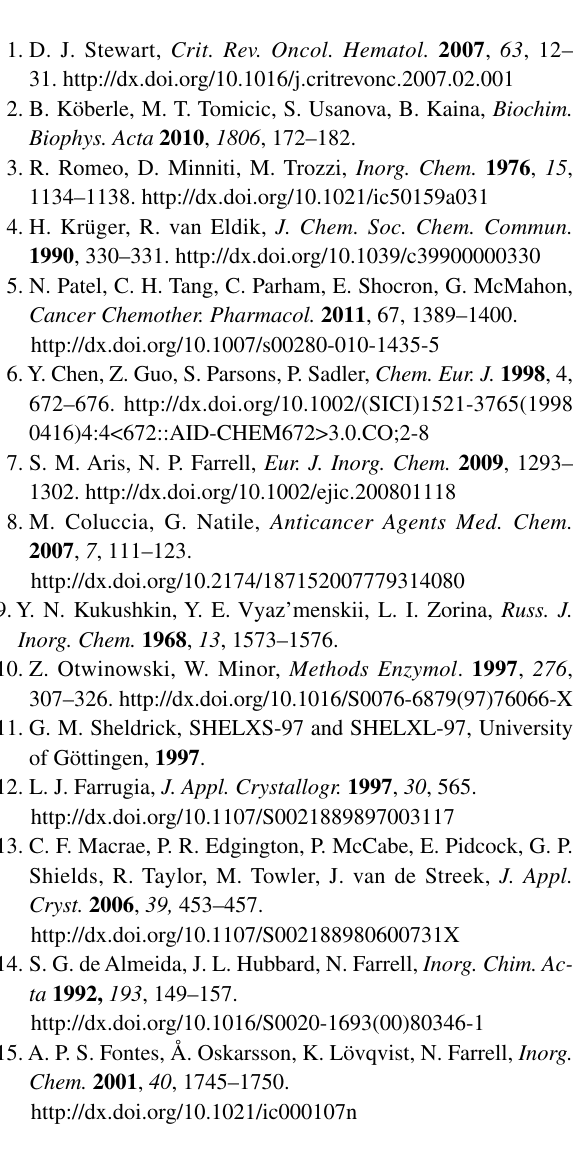
The specific C1(a dmso methyl group)···Cl1 [ – x